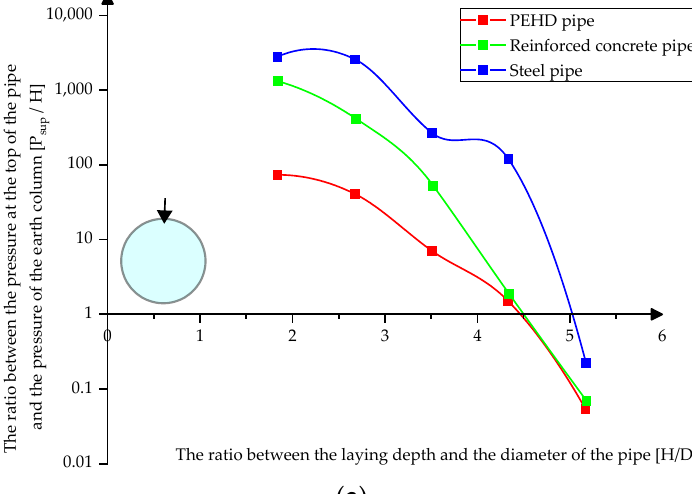
Figure 8. Shock wave propagation speed variation ( a ) in sandy soils ( b ) in clay soils.